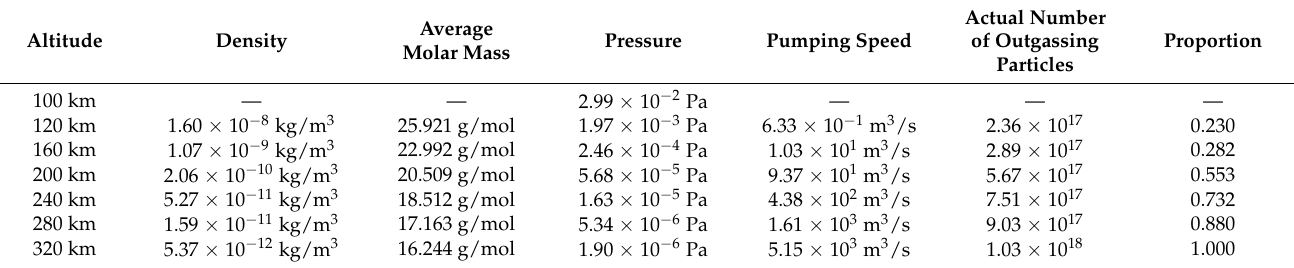
Table 8. Data related to outgassing at different altitudes under the LL